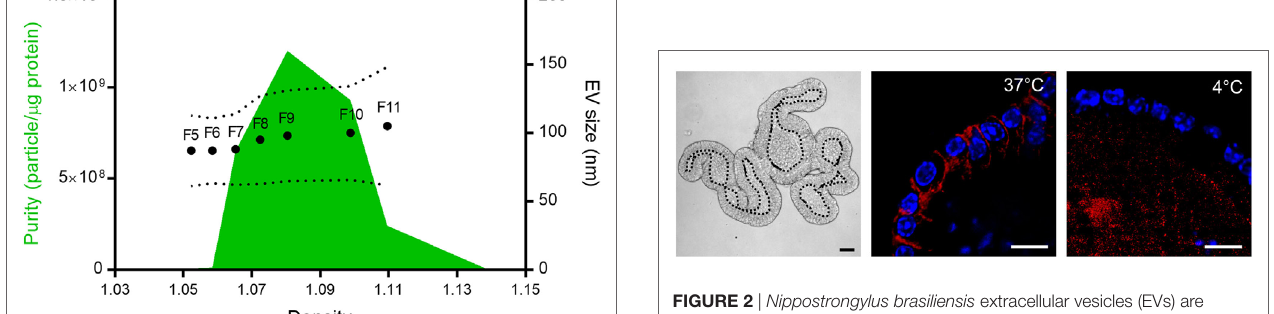
FigUre 2 | Nippostrongylus brasiliensis extracellular vesicles (EVs) are internalized by murine small intestinal (SI) organoid cells. Representative laser scanning confocal microscopy images (Zeiss 780 NLO) of PKH26-labeled EVs (red) at 37 and 4°C (metabolically inactive cells). EVs are internalized by cells within organoids at 37°C 3 h after particle-injection into the organoid central lumen (corresponding to the luminal side of the gut). Hoechst dye (blue) was used to label cell nuclei. Left panel demonstrates a bright field image (Zeiss AxioImager M1 ApoTome) of the tissue architecture of a murine SI organoid. Central lumen of the organoids is separated by the dotted line from the epithelial cell layer. Bar corresponds to 10